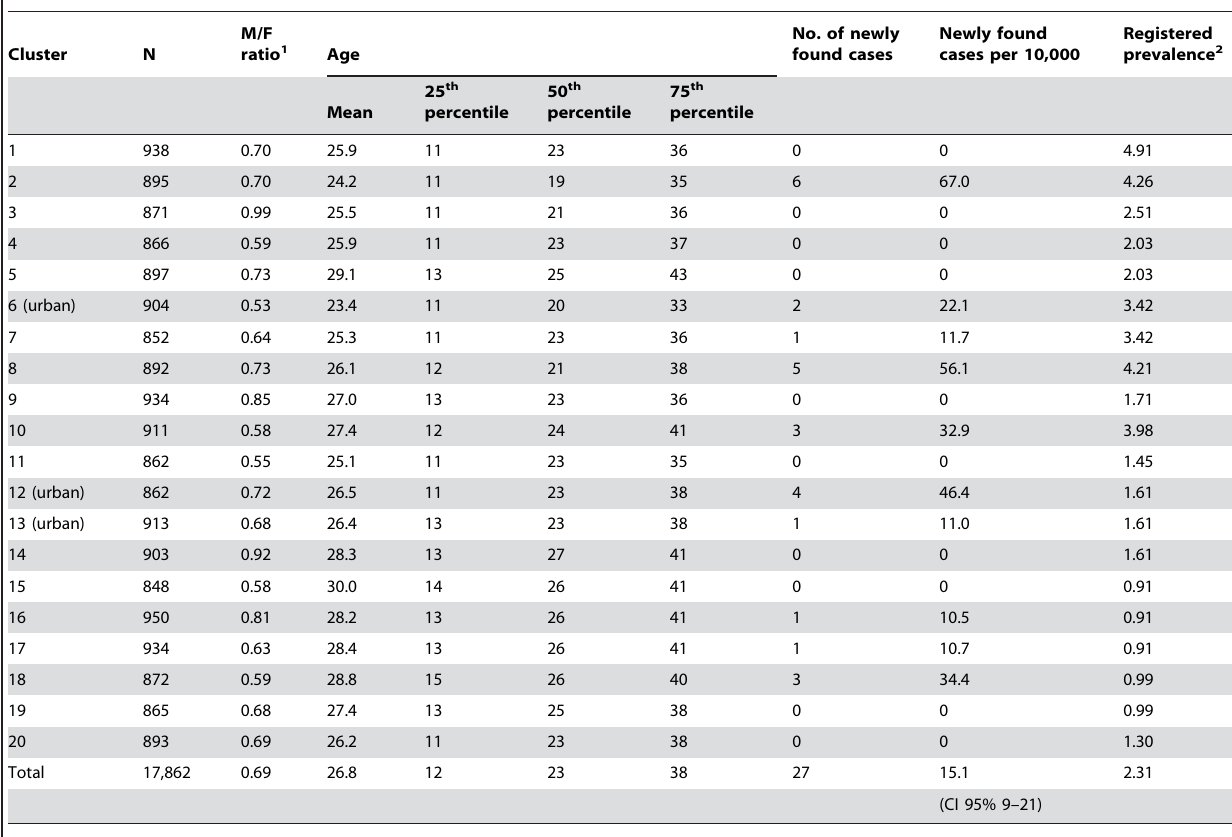
Table 1. Sex, age, newly found leprosy patients by cluster.